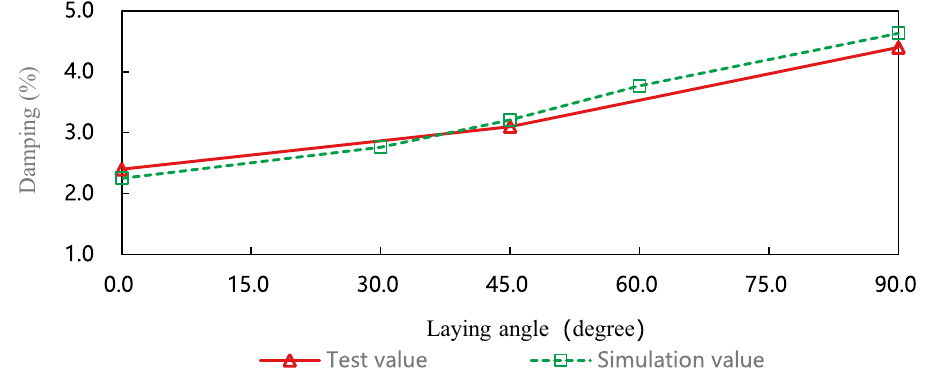
Figure 9. The damping contrast curves of leaf springs with different laying angles.